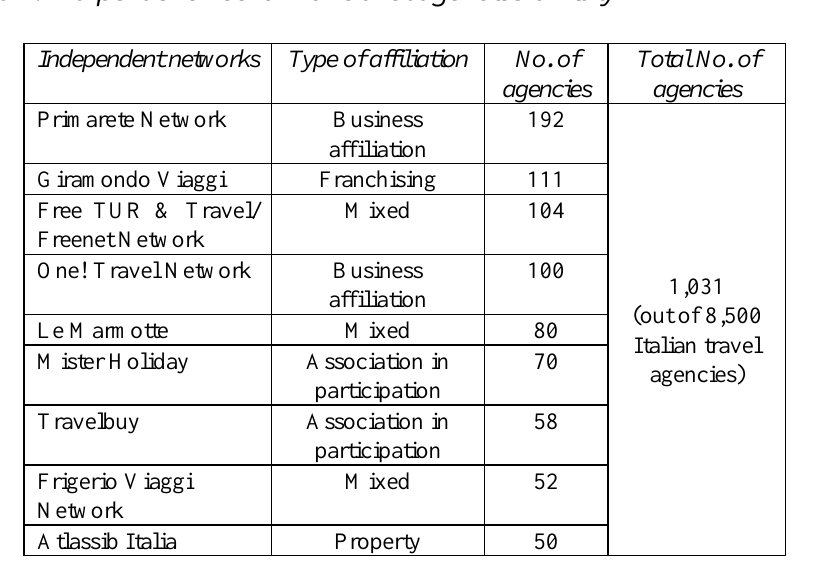
Total No. of agencies